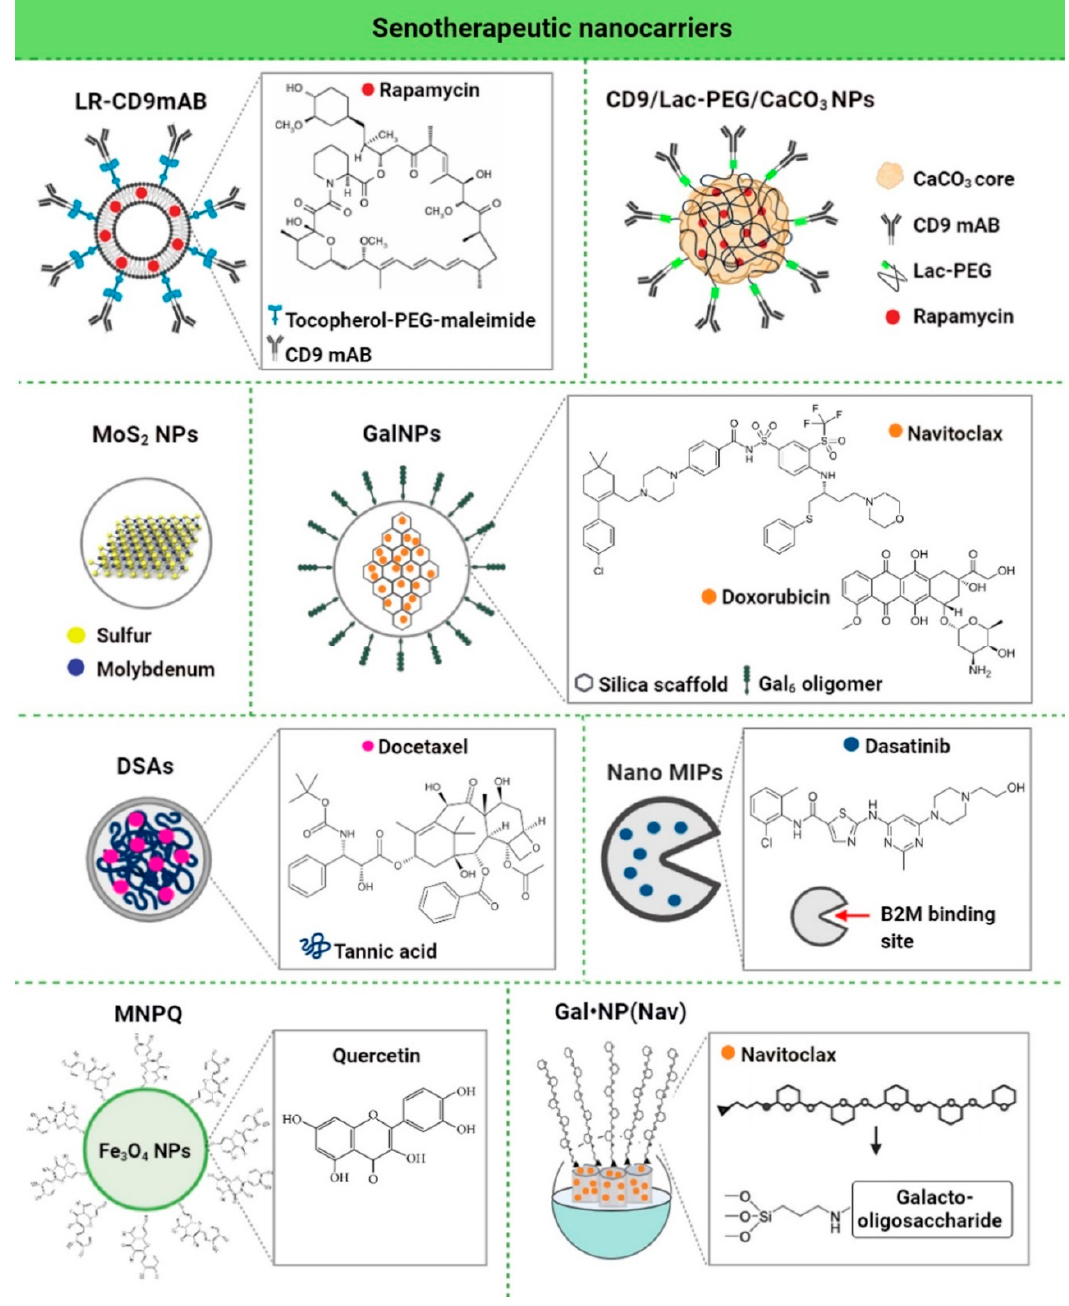
Figure 4. Different examples of nanocarriers used for targeted delivery of senolytics/senomorphics to senescent cells. Chemical structures of the loaded cargos are presented. LR, rapamycin-loaded PEGylated liposomes; NPs, nanoparticles; PEG, polyethylene glycol; Lac-PEG, lactose-polyethylene glycol; Gal, galacto-oligosaccharide; DSAs, docetaxel-tannic acid self-assemblies; NanoMIPs, molecularly imprinted nanoparticles; B2M, beta-2 microglobulin; Gal 6 , 6-mer galacto-oligosaccharide; Nav, navitoclax; MNPQ, quercetin surface-functionalized Fe 3 O 4